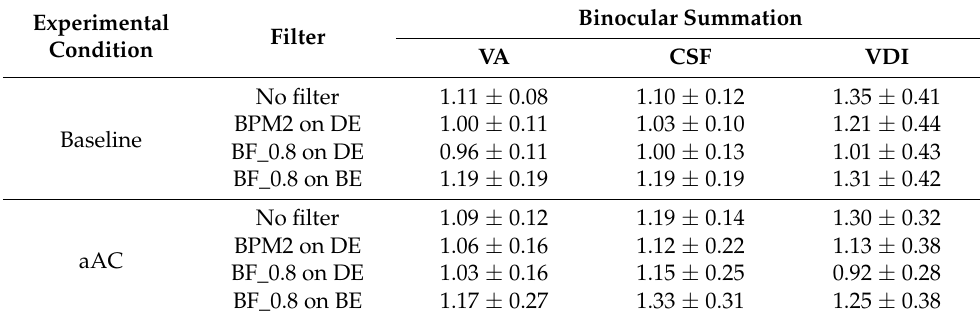
Table 4. Mean values of the binocular summations (Visual Acuity, VA; averaged Contrast Sensitivity Function, CSF; and Visual Disturbance index, VDI) under the different experimental conditions, baseline (no alcohol consumption) and aAC (after alcohol consumption) and for different filter conditions: no filter, BPM2 fog filter on the dominant eye (BPM2 on DE), Bangerter foil BF_0.8 on